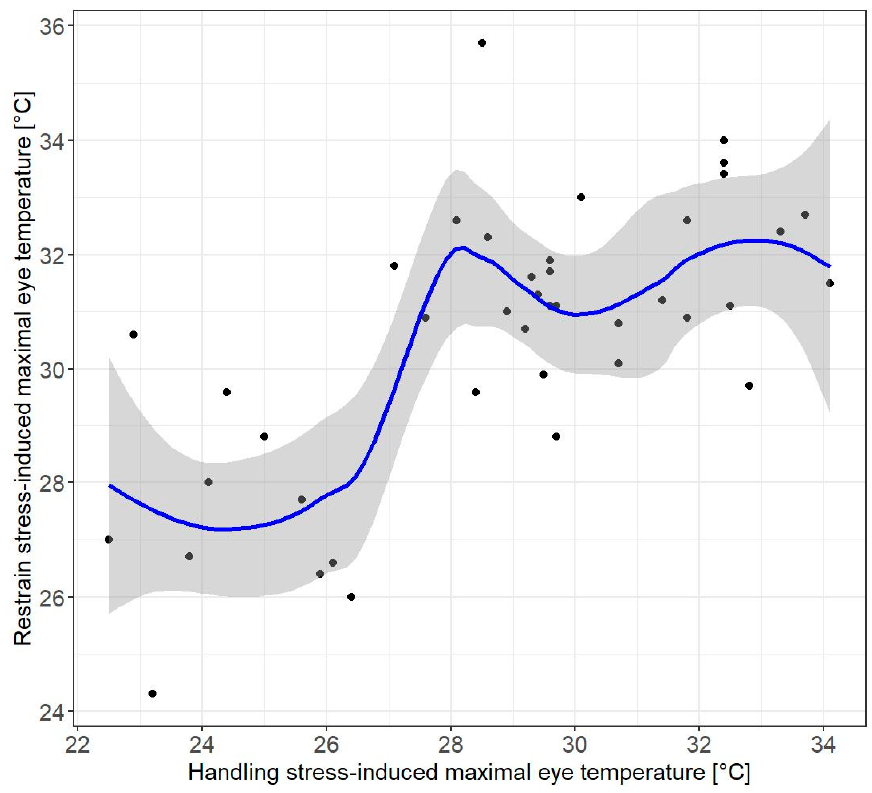
Figure 3. Relationship between handling, stress-induced eye-region temperature, and restrain stress-induced eye-region temperature. Smooth curve fitted by local polynomial regression (loess).